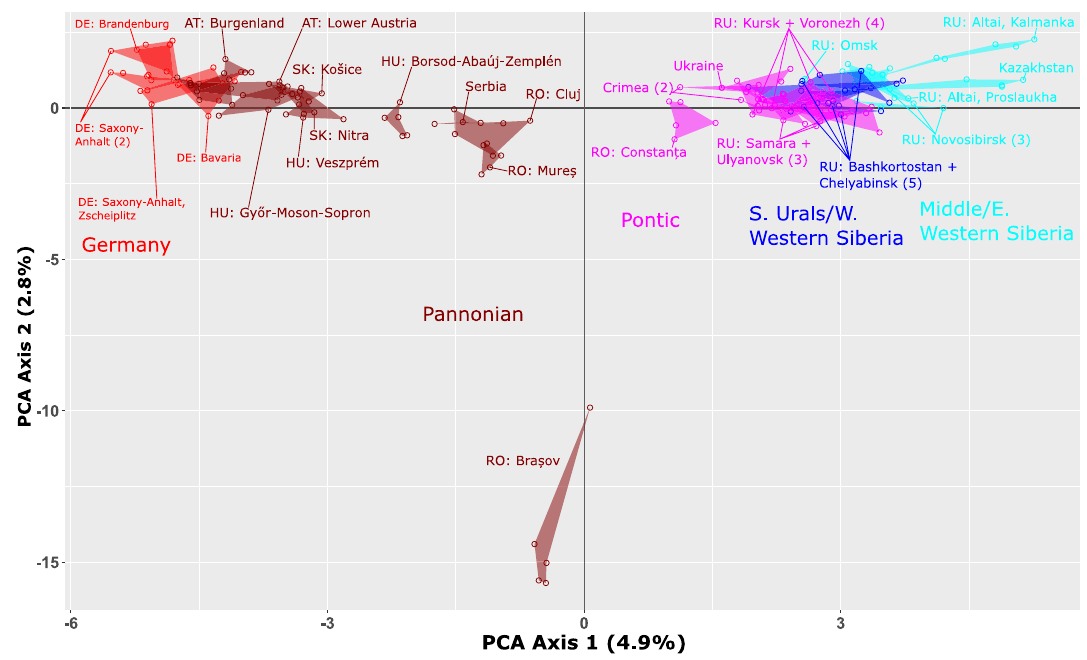
Figure 3. Principal Component Analysis of GBS data of the eastern lineage of Adonis vernalis (ingroup dataset without the Spanish population; 8,015 unlinked SNPs with a maximum of 10% missing data per locus). The colour-coding refers to the geographic groups defined in Fig. 1. Two-letter abbreviations are ISO alpha-2 country codes. Overlapping populations (mainly from the Southern Urals and Western Siberia) are not all labelled at the population level. The numbers in parentheses indicate the number of populations (if more than